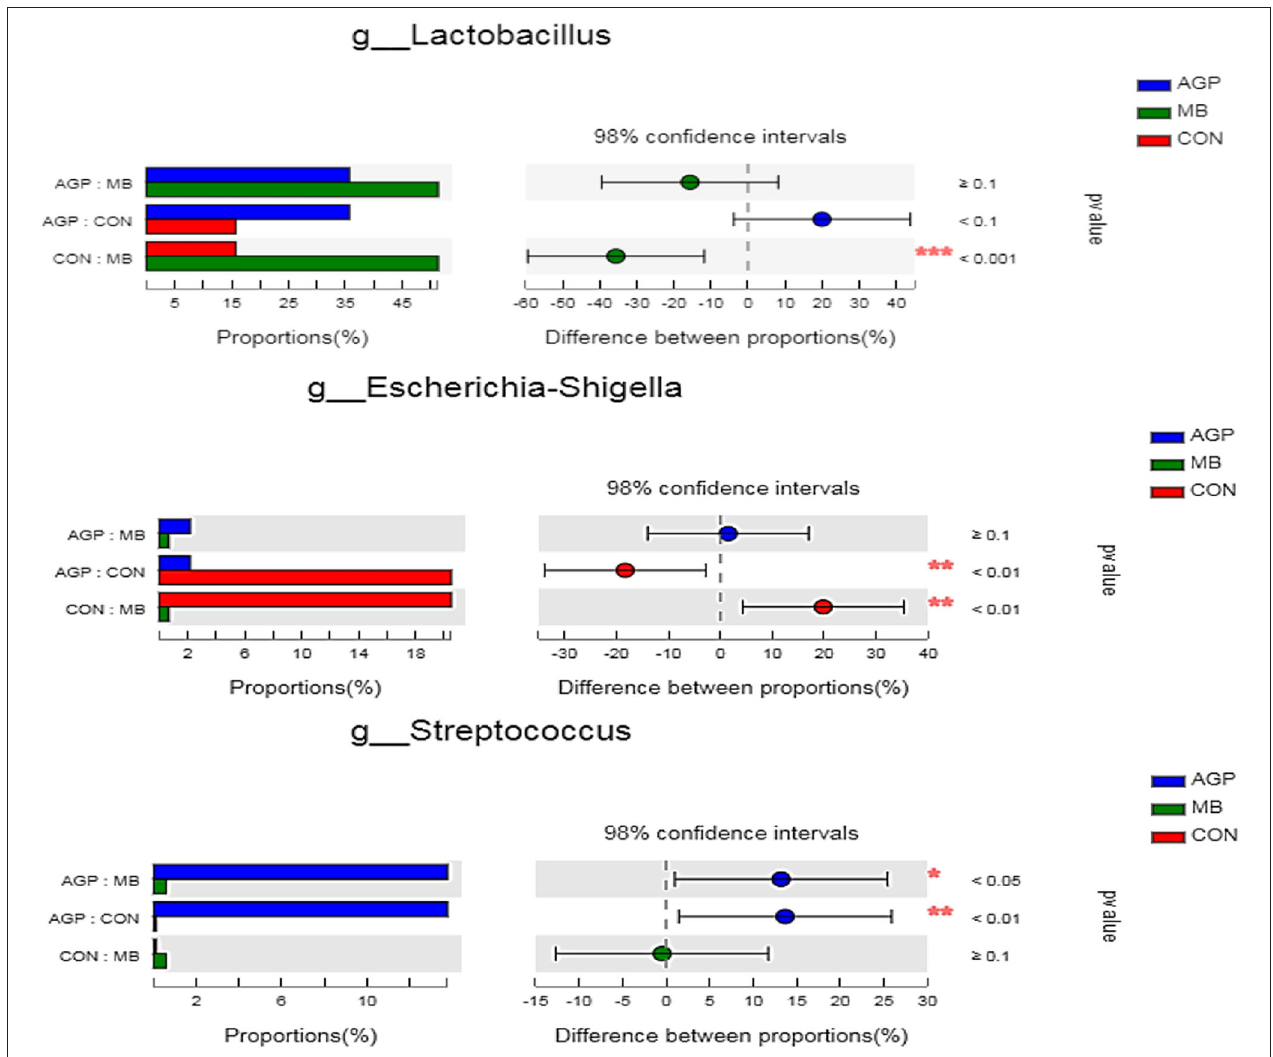
FIGURE 5 | Comparative analysis of 3 most relative abundances of gut microbiota at the genera level. Kruskal–Wallis test followed by Tukey test was used to evaluate the statistical significance. Asterisks express statistical differences between different groups: *0.01 < P ≤ 0.05, **0.001 < P ≤ 0.01, *** P ≤ 0.001. CON, basal